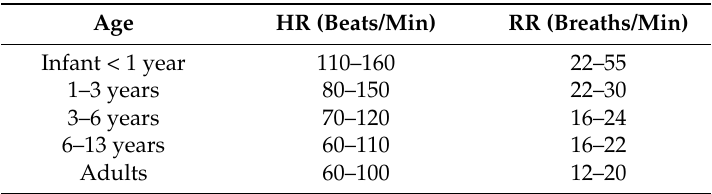
Table 2. A normal range of physiological signs (Adapted from website: https://www.acls-pals-bls. com/algorithms/pals/). HR, heart rate; RR, respiratory